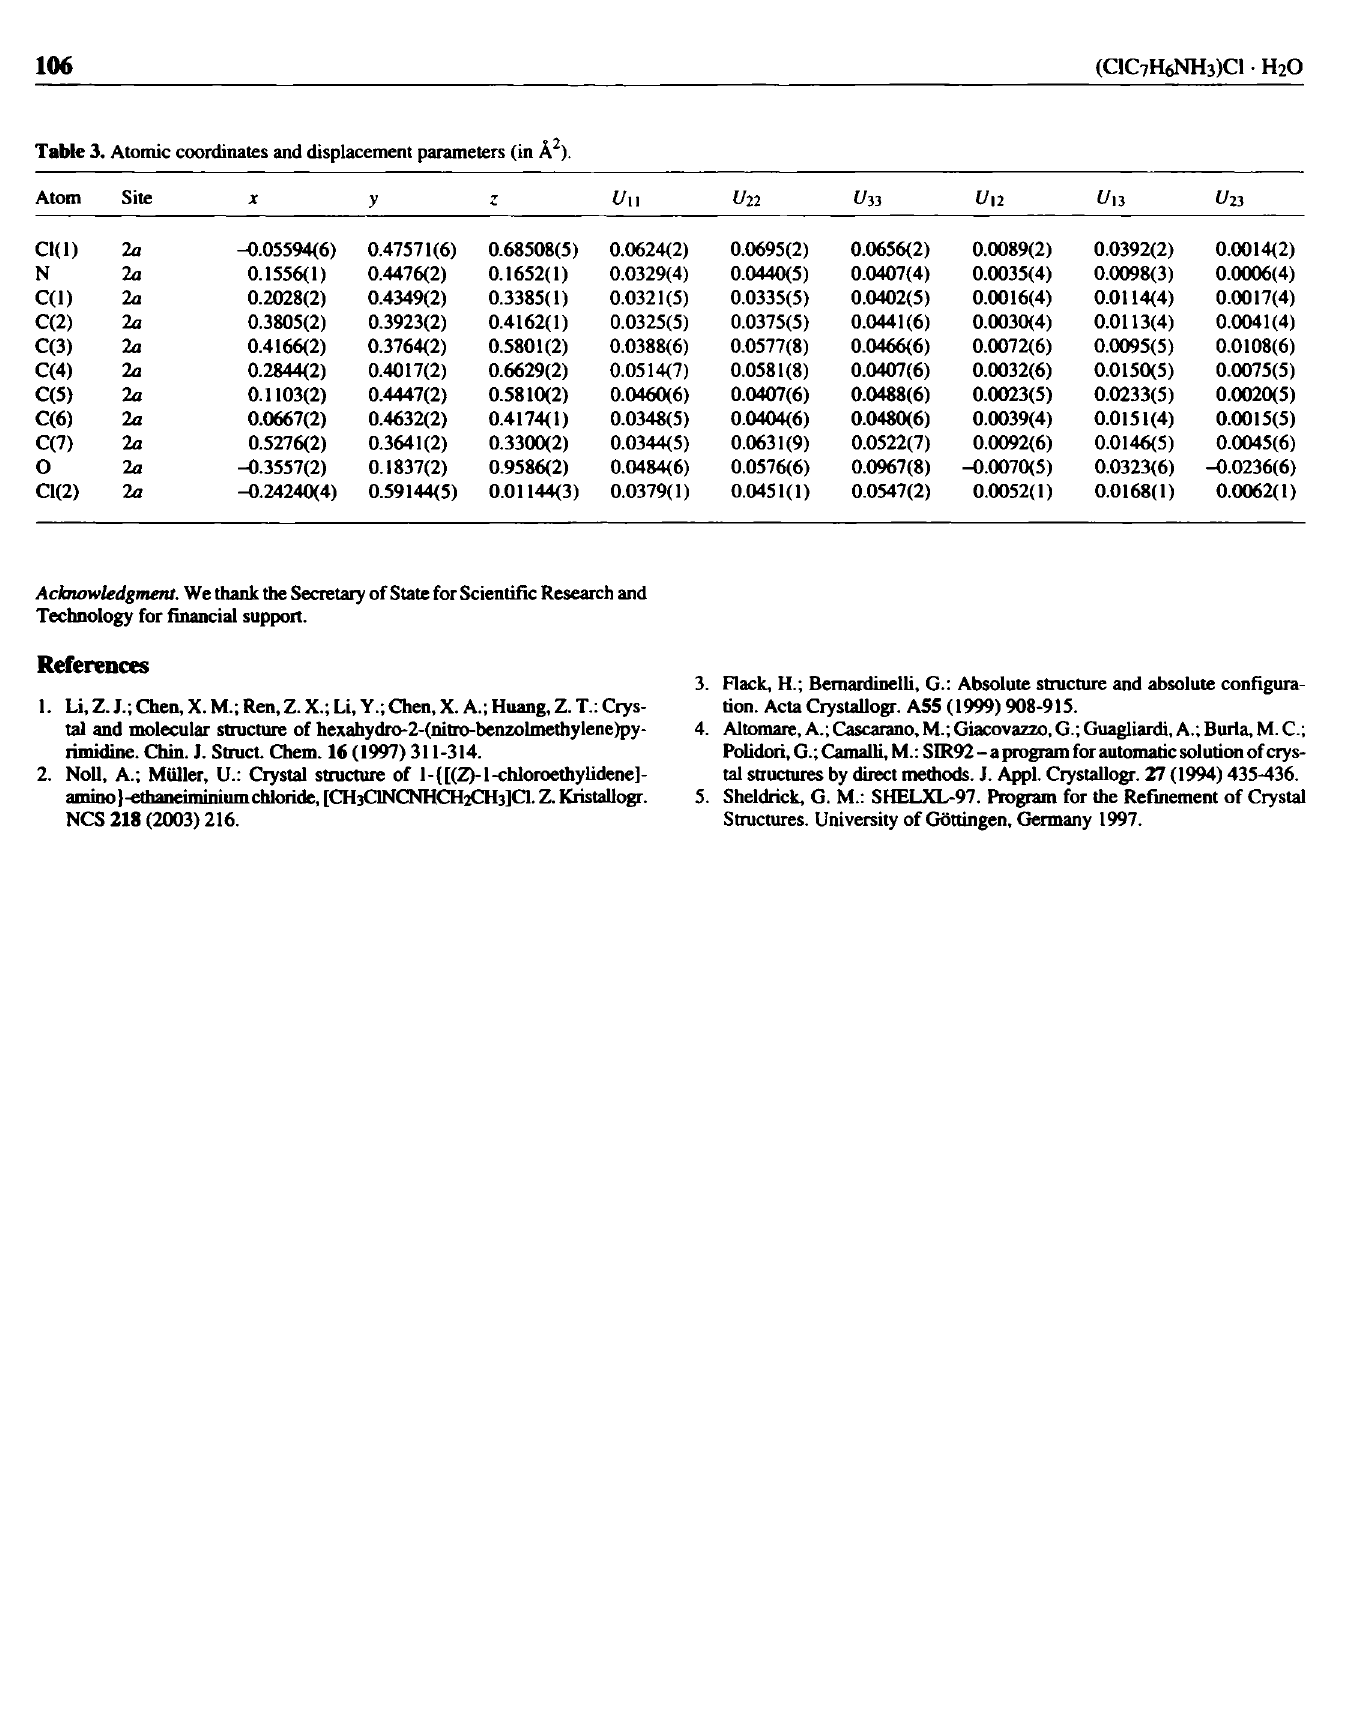
Table 3. Atomic coordinates and displacement parameters (in A 2